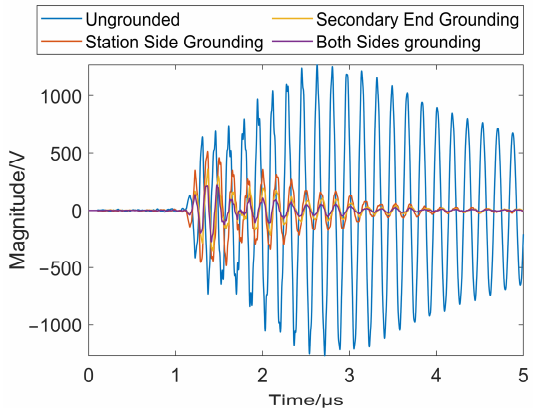
Figure 8. Disturbance voltage level under different grounding